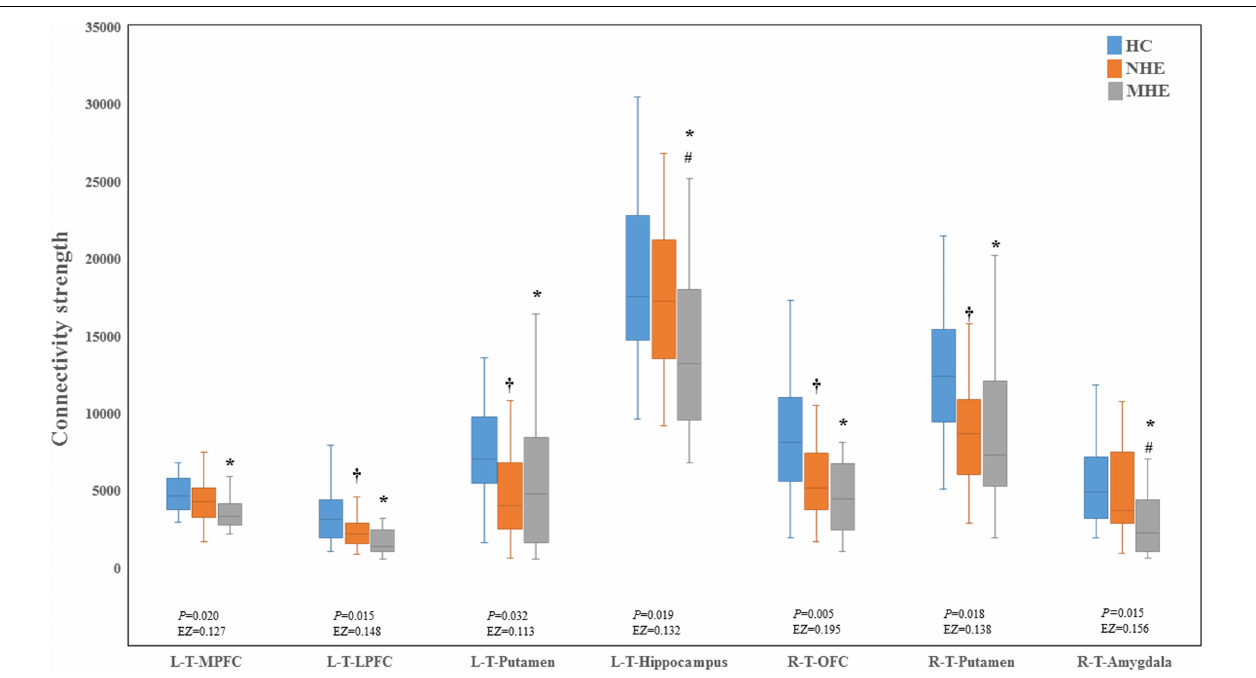
FIGURE 2 | Between-group differences in connectivity strength. The false discovery rate (FDR)-corrected P values and the effect size (EZ) are shown. The symbols *, † , and # indicate significant differences in MHE vs. HC, NHE vs. HC, and MHE vs. NHE, respectively. MHE, minimal hepatic encephalopathy; NHE, patients without MHE; HC, healthy control; LPFC, lateral prefrontal cortex; MPFC, medial prefrontal cortex; OFC, orbitofrontal cortex; T, thalamus; L, left; R,